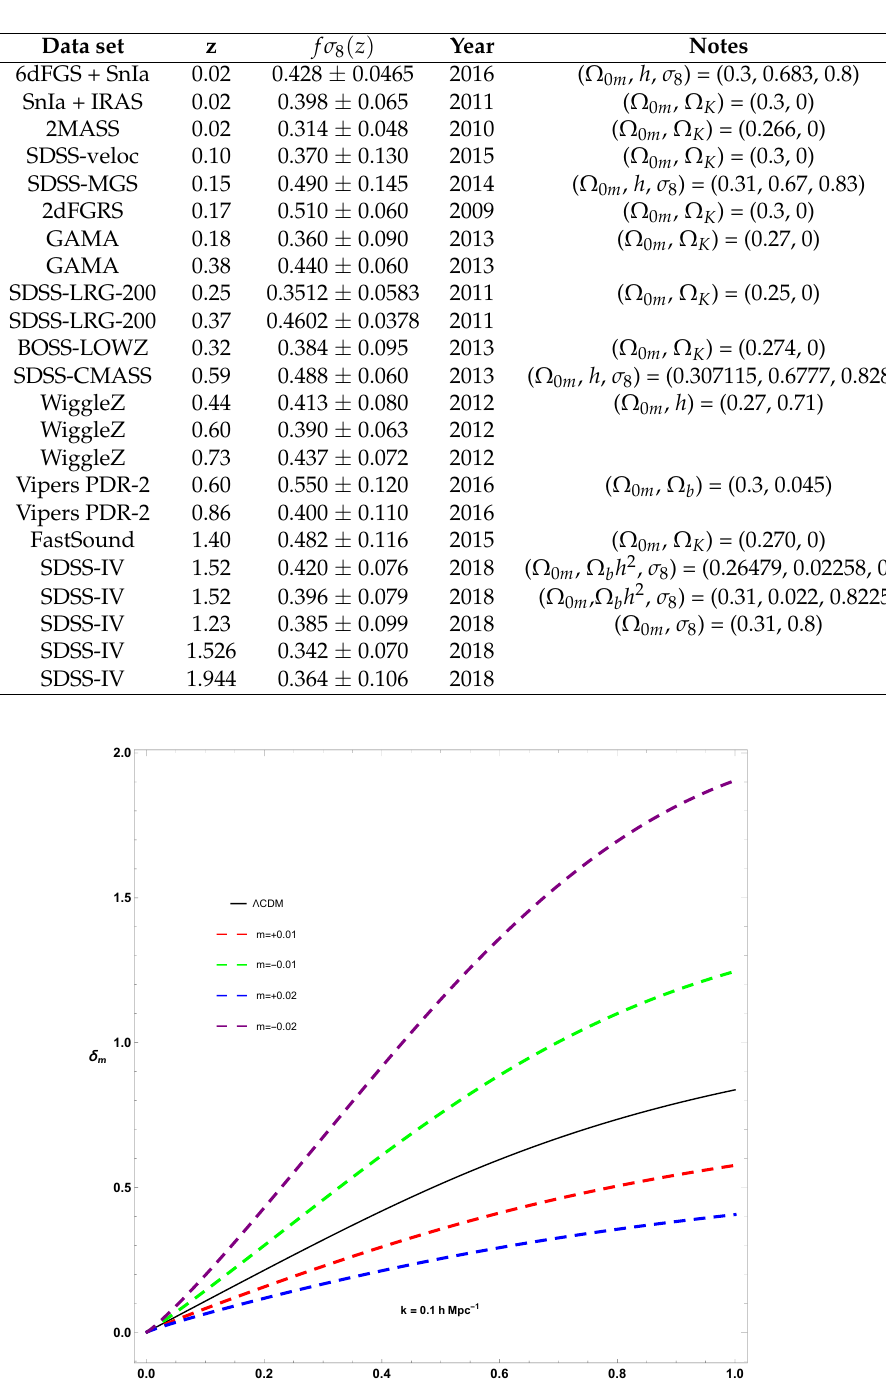
Table 1. Data points for our analysis. The first 18 entries represent the “Gold” set of [45]. The entries 19 and 20 are taken from [46,47], respectively. The last three values have been reported in [48].